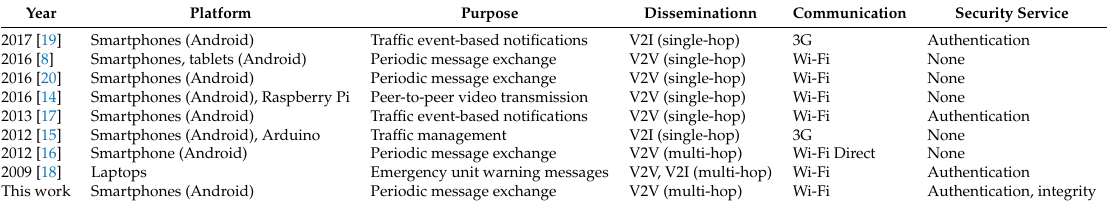
Table 1. Smartphone-based vehicular ad-hoc network (VANET) platforms in the